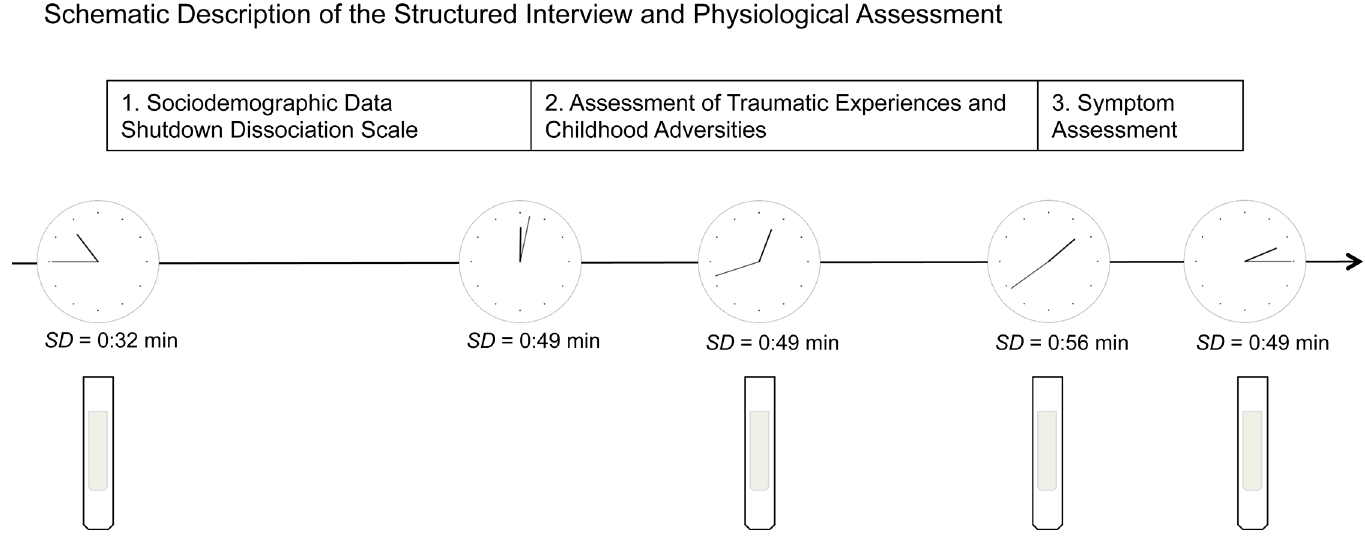
Fig 1. Schematic Description of the Interview